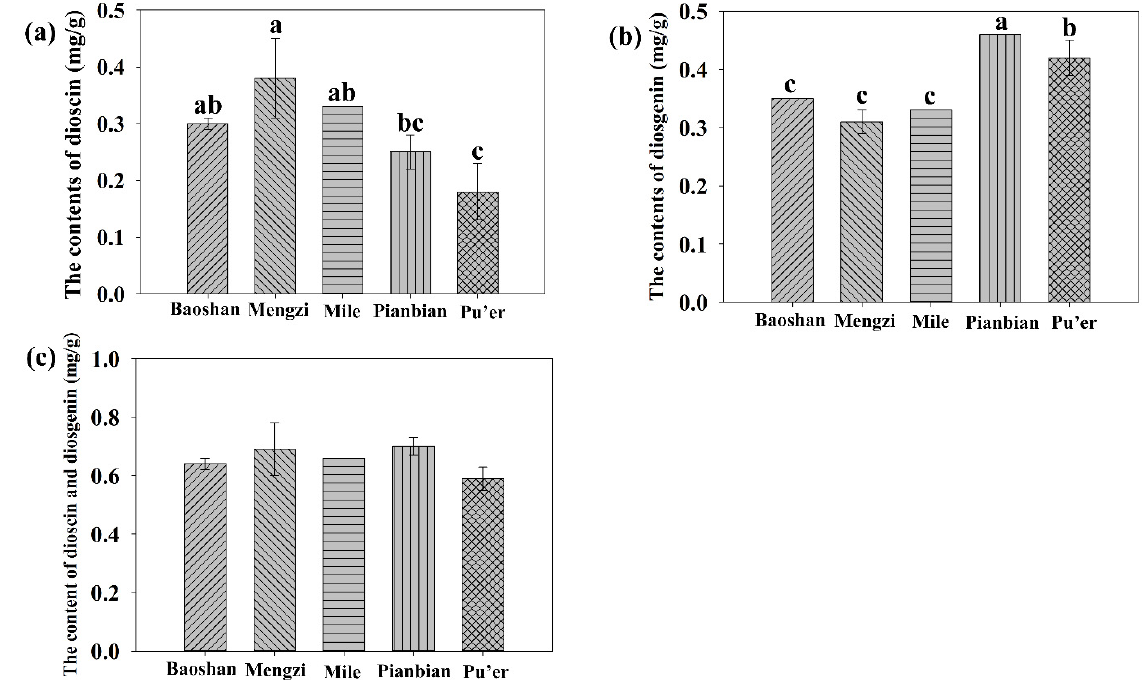
Figure 8. The contents of dioscin ( a ), diosgenin ( b ) and the sum (dioscin and diosgenin) ( c ) in the rhizomes of Polygonatum kingianum planted in five different areas, including Baoshan Prefecture (BS), Mengzi Prefecture (MZ), Mile Prefecture (ML), Pingbian Prefecture (PB) and Pu’er Prefecture (PE). Different lowercase letters represent the difference of contents of dioscin, diosgenin or the sum among the five samples, p ≤ 0.05. There is no difference among bars of ( c ). Error bars indicate mean values ± SD, ( n = 3). BS: Baoshan Prefecture; MZ: Mengzi Prefecture; ML: Mile Prefecture; PB: Pingbian Prefecture; PE: Pu’er Prefecture.